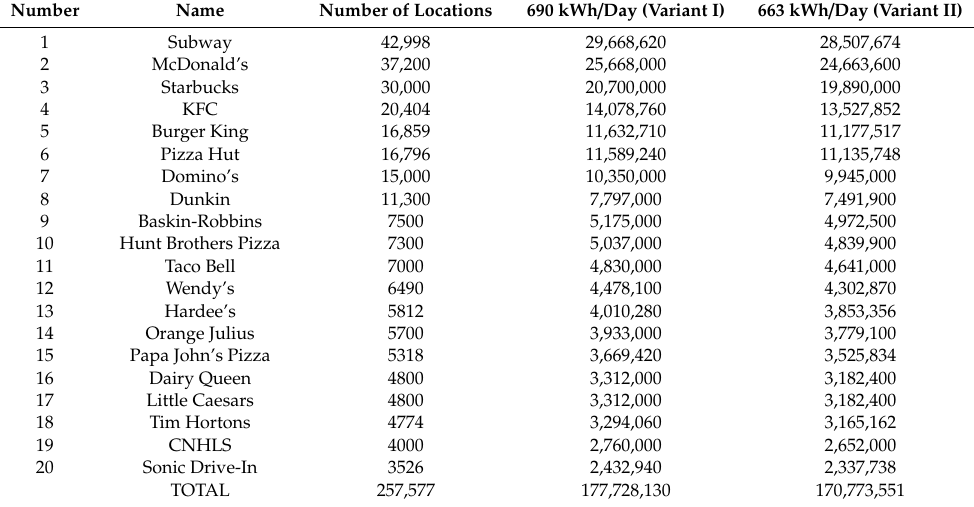
Table 11. Number of Restaurants belonging to a particular chain located globally for two examples of energy consumption by individual restaurant and estimates of their daily energy consumption.